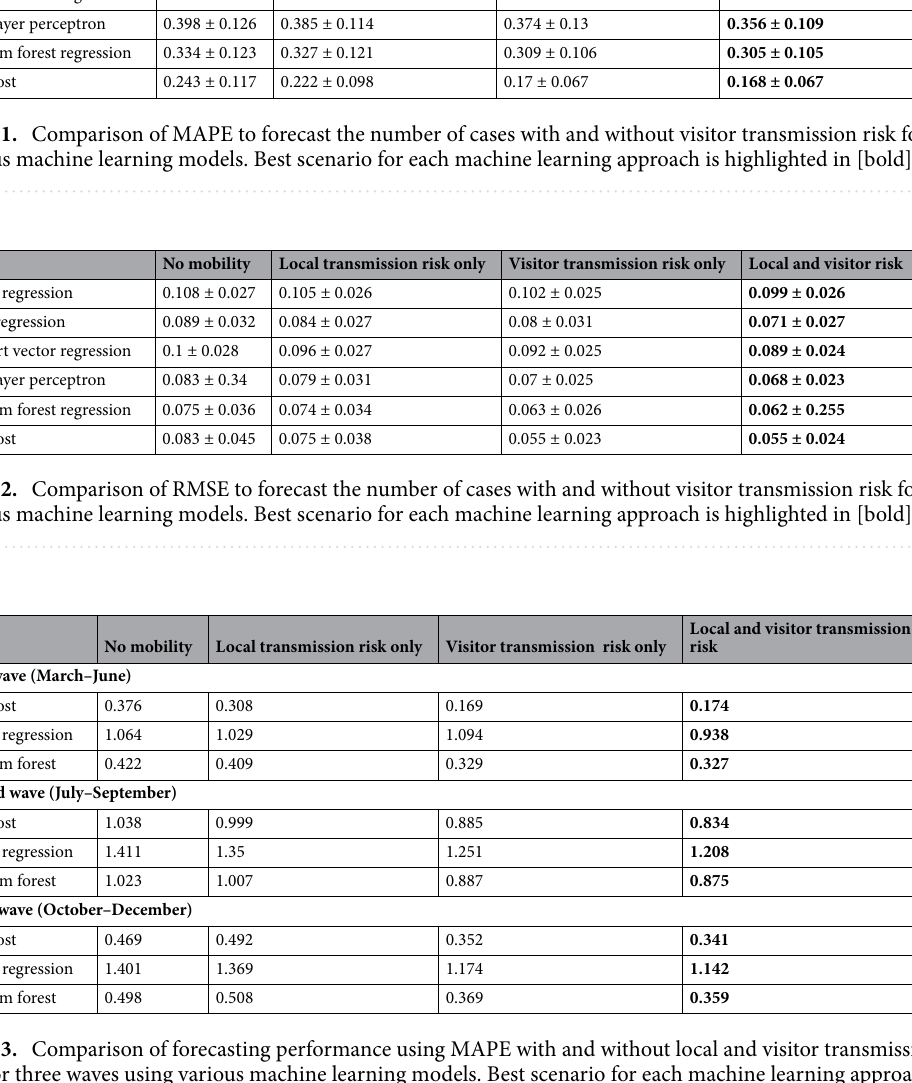
Table 3. Comparison of forecasting performance using MAPE with and without local and visitor transmission risk for three waves using various machine learning models. Best scenario for each machine learning approach is highlighted in